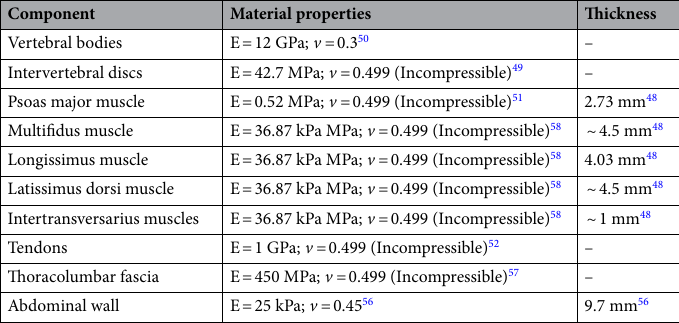
Table 2. Material properties used for the full spine validation test.